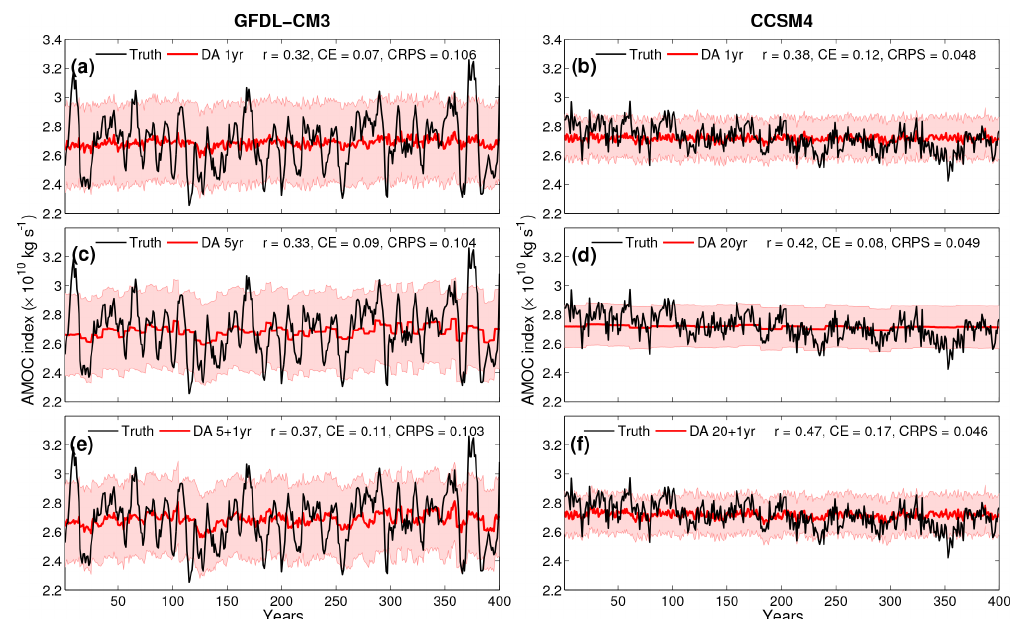
Figure 8. AMOC index reconstructions (mean of 100 Monte Carlo iterations, with error bars indicating ± 2 σ of the iterations and analysis ensembles) for the three types of experiments discussed in the text and for each climate model simulation. Black lines indicate the true time series, while red lines indicate the reconstructed time series for only short-timescale (annual) pseudoproxies, only long-timescale (5 or 20 years) pseudoproxies, and both long- and short-timescale pseudoproxies. Skill metrics of the reconstructions, correlation ( r ), coefficient of efficiency (CE), and mean continuous ranked probability score (CRPS) are shown at the top of each